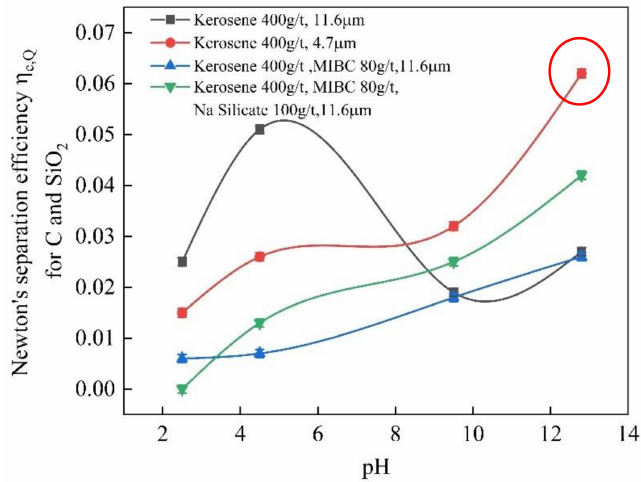
Figure 8. Results of flotation using only kerosene for shungite of 4.7 µ m and flotations using only kerosene, MIBC + kerosene, and MIBC + sodium silicate + kerosene for shungite of 11.6 µ m.